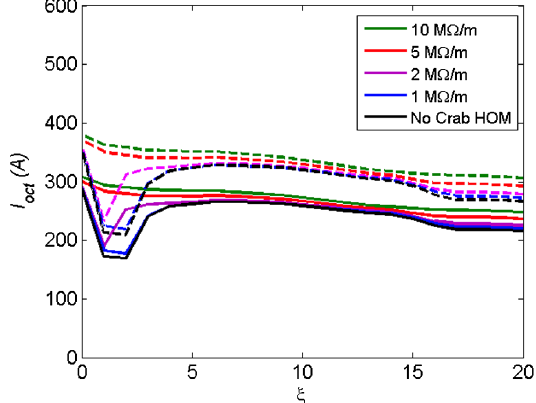
FIG. 11. In order not to affect the HL-LHC operational scenarios the HOM shunt impedance has to be kept below ∼ 1 M Ω =m . NHT simulation for the top energy of E ¼ 7 TeV; ultimate operational scenario, β (cid:1) ¼ 41 cm, standard (solid lines) and BCMS (dashed lines) beam